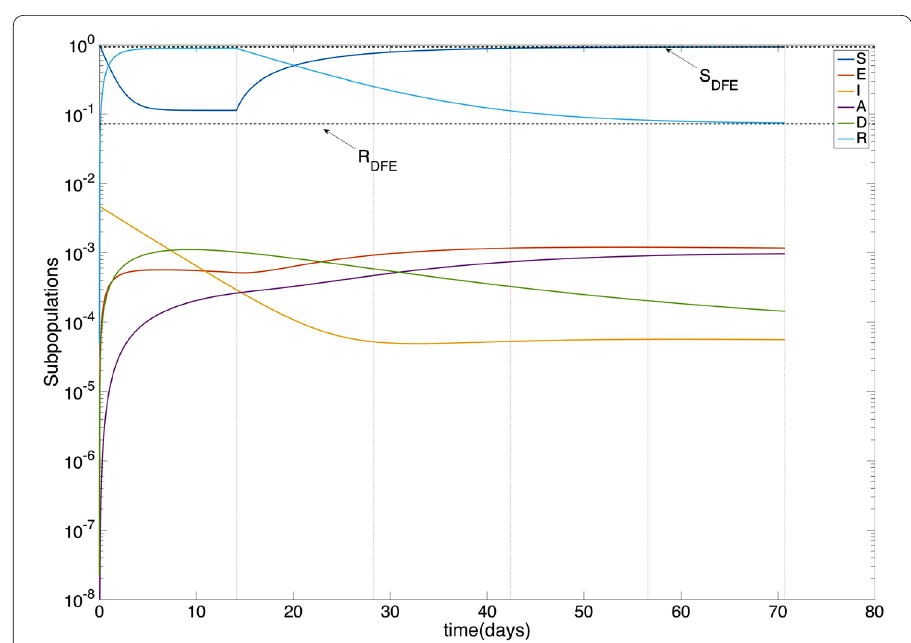
Figure 9 Dynamics of the subpopulations under supervised control